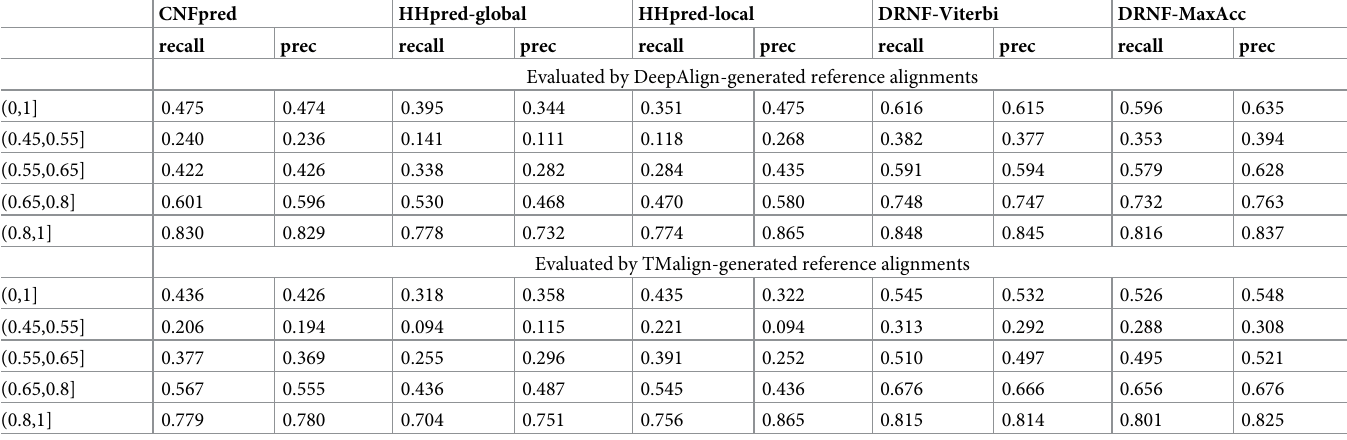
Table 1. Reference-dependent alignment accuracy (precision and recall) on our in-house